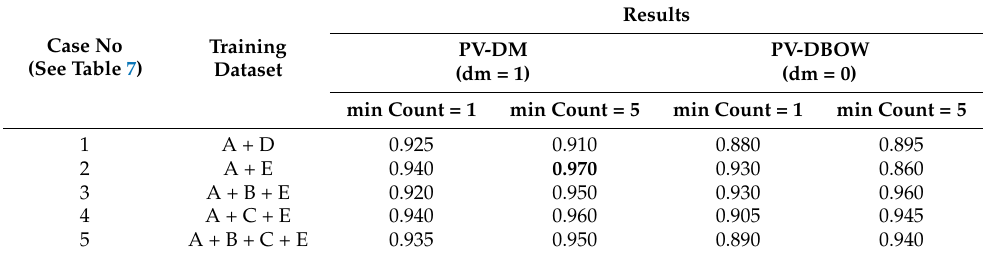
Table 10. Results of Experimental setup #2.